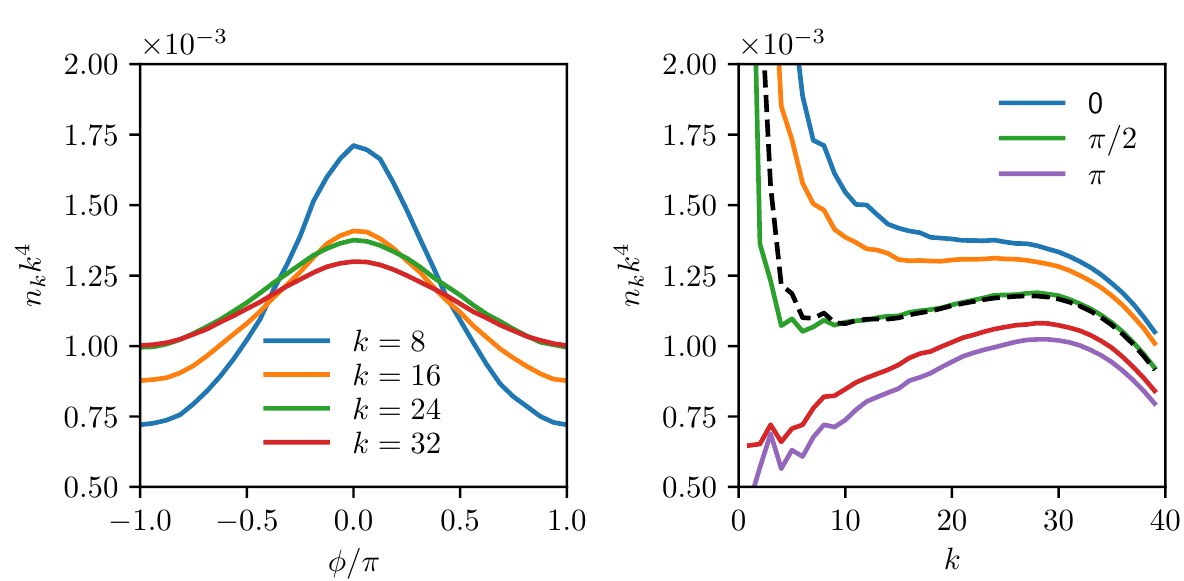
Figure 5. Angular ( left ) and radial ( right ) slices of the spectra averaged over 10 runs in the local frame along the instanta- neous anisotropy vector, as in Figure 3. f = 0.002.